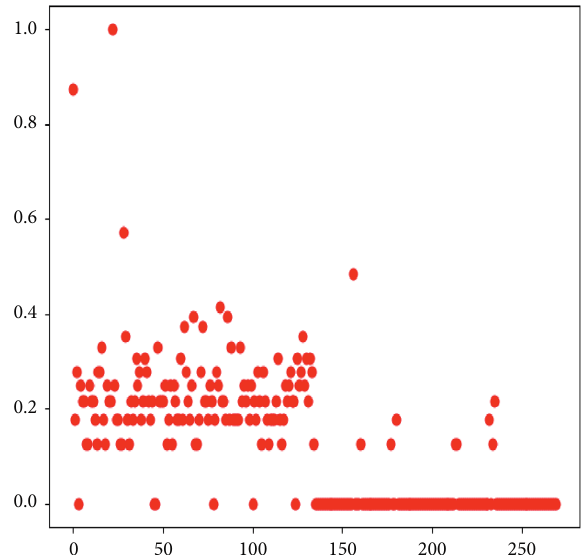
Figure 9: Similarity matching results with fusion size of 160.